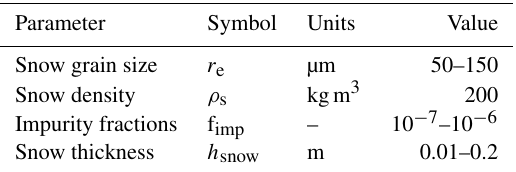
Table A3. Physical parameters of snow cover. The snow grain size and snow thickness were generated with a randomly uniform distri- bution in the specified